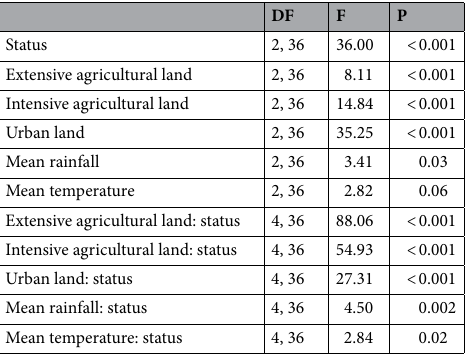
Table 1. LMMs results obtained for the best selected model after Multi Model Inference analysis. Status referred to natural, casual or naturalised exotic species. Degree of freedom (DF), F value of the statistic (F) and significance level (P) are